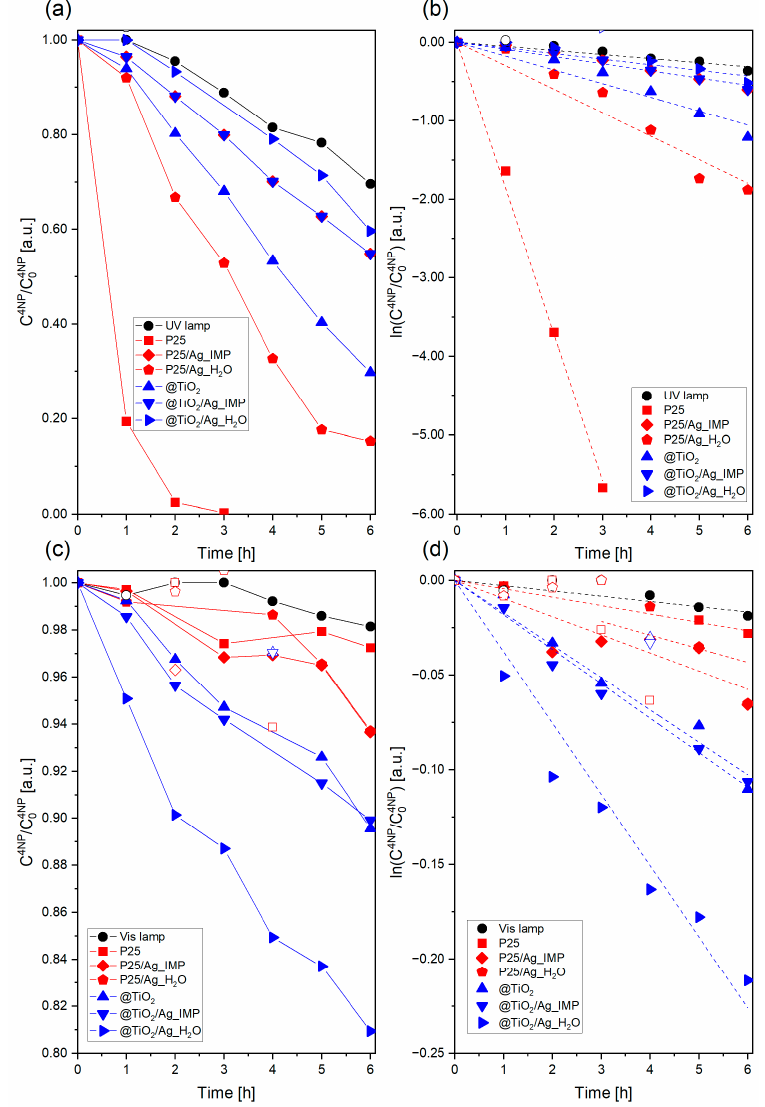
Figure 7. Results of photocatalytic oxidation of 4NP using UV radiation source ( a ) and Vis imitating source ( c ) with fitting first kinetic order model to experimental data ( b , d ) collected for @TiO 2 and P25 materials before and after deposition of Ag using two different methods—IMP and H 2 O. Empty sca tt er points were excluded from linear fi tt ing. Table 3. Kinetic parameters of fi rst kinetic order model determined for photocatalytic oxidation of 4NP using UV and Vis source on @TiO 2 and P25 materials before and after deposition of Ag using two di ff erent methods—IMP and H 2 O.